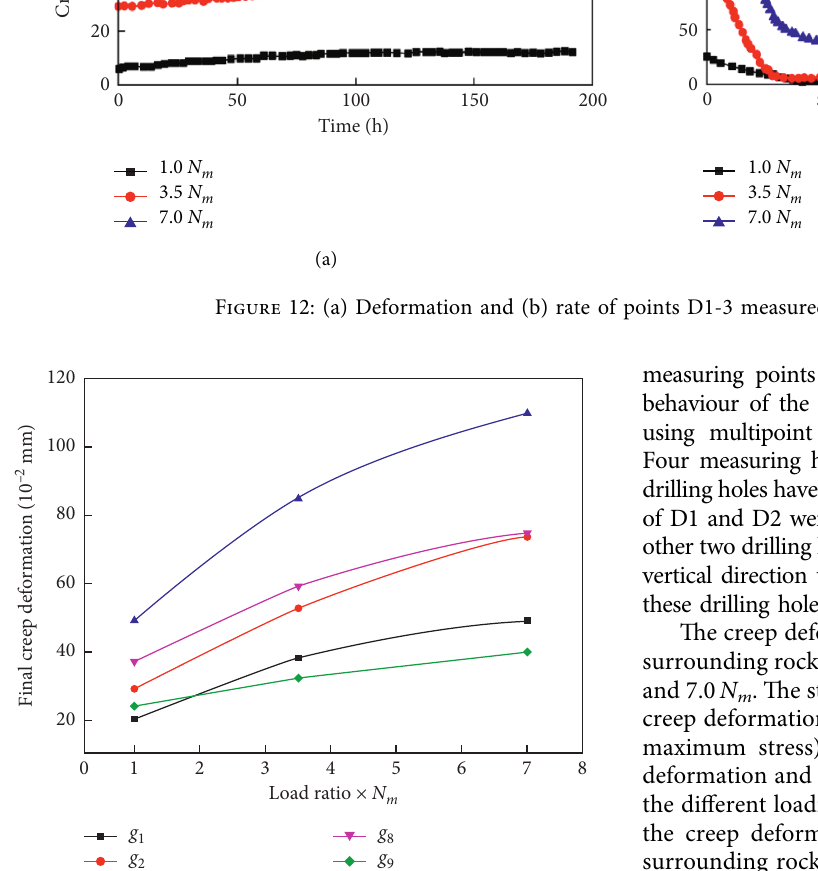
, g , g ,g , and g 1 2 5 8